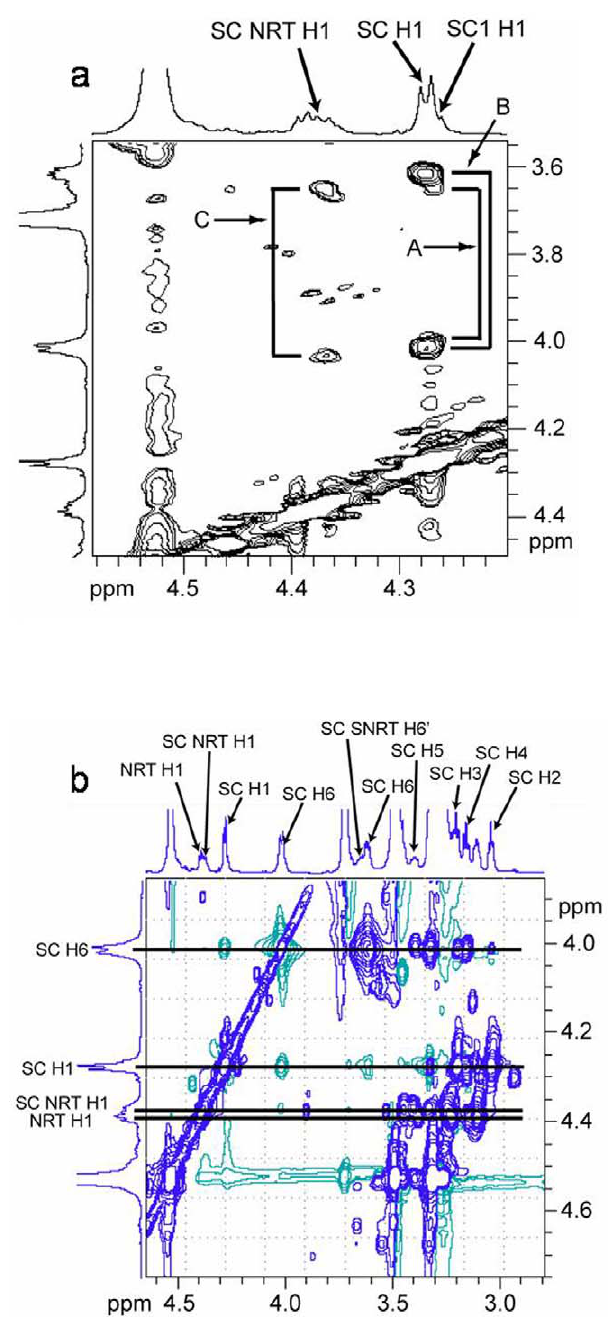
Figure 5. 2D NMR spectra of the glycosidic linkages and non- reducing termini of the (1 R 3,1 R 6)- b -D-glucan isolated from C. glabrataace2 strain. (a) The three different (1 R 6)- b -linked glycosidic bonds from the side chain are detailed in the NOESY 2D NMR spectrum for SC1, SC Internal, and SC NRT glucosyl groups associated with H1 SC1, SC H1 and SC NRT H1. A: H6Br,H6 9 Br/H1SC1; B: H6SCn,H6 9 SCn/ H1SC(n + 1); C: H6SC(n-1),H6 9 SC(n-1)/H1SCNRT. (b) Similarity of the structures of the glycosyl group associated with SC NRT H1 and NRT H1 is indicated in the TOCSY 2D NMR spectrum.